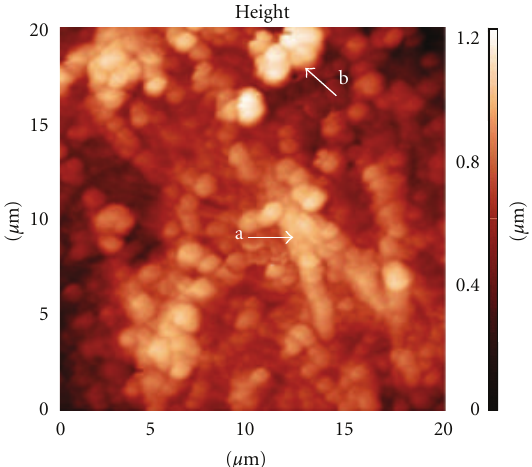
Figure 3: Granular structure of the bone matrix of the femur in healthy rats. Ordered arrangement of granular structures repeats the form of collagen fibrils. AFM scan size of 10 microns. Grain of regular structure (arrow a). Grain of irregular structure (arrow b).